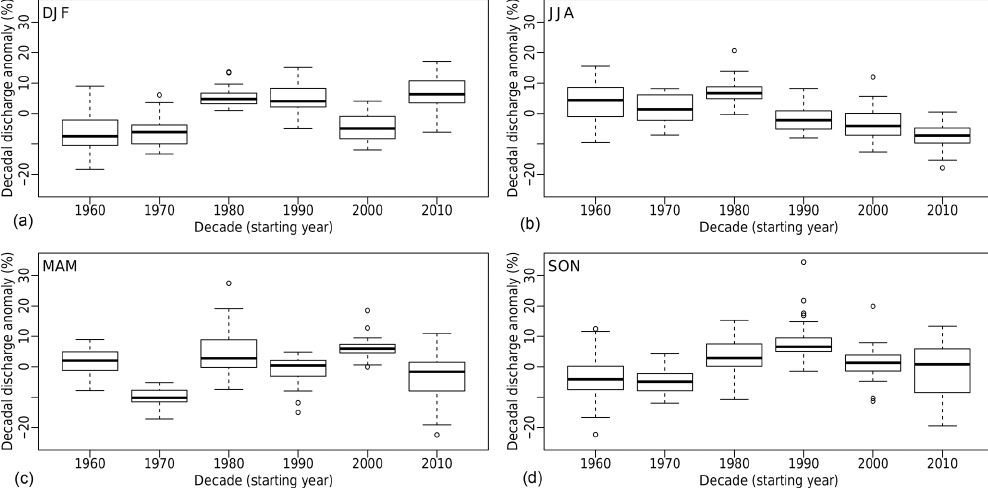
Figure 9. Discharge seasonal relative anomalies for the 26 catchments where data are available since 1960 (see Table 1). Anomalies with respect to the 1960–2018